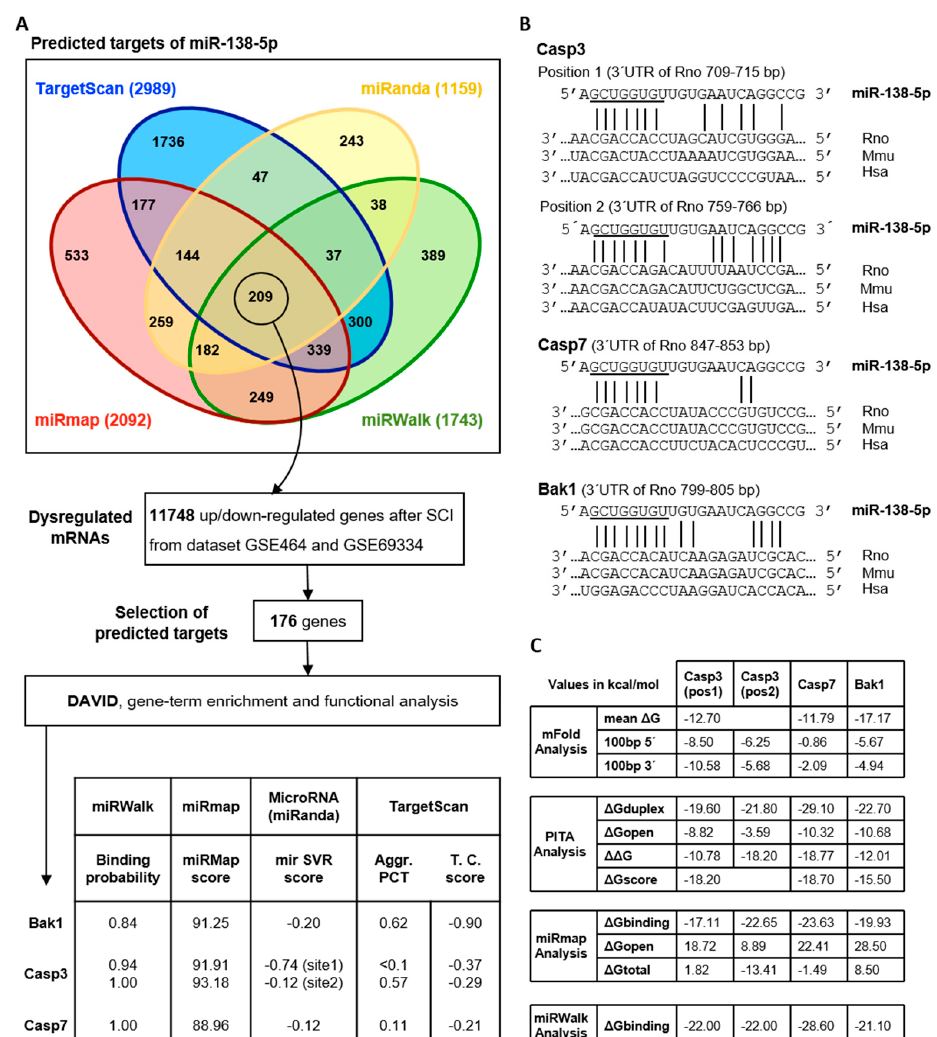
Figure 4. Bioinformatics analyses of miR-138-5p targets among pro-apoptotic proteins overexpressed after SCI: ( A ) Description of the analysis and major results in the identification of SCI-induced apoptotic targets of miR-138-5p. The upper Venn diagram shows the number of miR-138-5p target genes predicted by miRmap, TargetScan, miRWalk, and miRanda. 209 targets predicted by all four algorithms (overlapping areas of the four predictive tools) were compared with gene profiling data from rat models of SCI (GEO datasets GSE464 and GSE69334). The biological functions of the miR-138-5p targets undergoing expression changes after SCI were analyzed with DAVID functional annotation tools. The table shows the miR-138-5p predicted targets related to apoptosis and their prediction scores: ( B ) Alignment of the seed regions of miR-138-5p with the 3 ′ UTR of Casp3, Casp7, and Bak1 in human (Hsa), mouse (Mmu), and rat (Rno). ( C ) Accessibility for the predicted targets according to mFold, PITA, miRmap, and miRWalk 3.0.